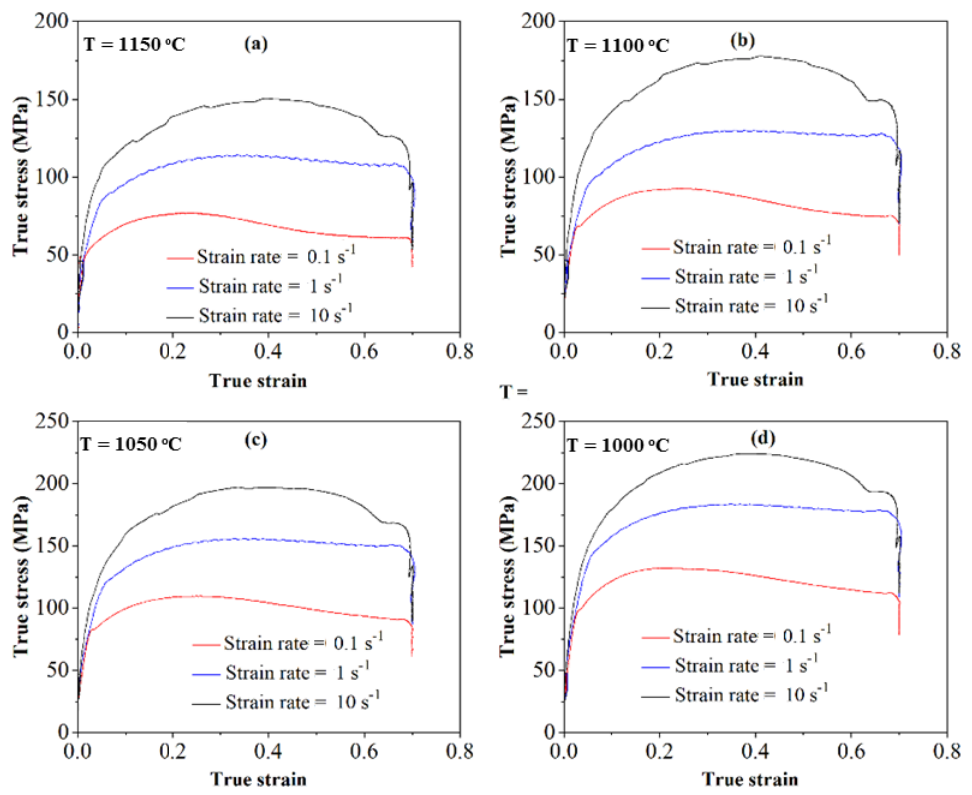
Figure 3. True stress – strain curves of 17-4PH steel at different temperatures and strain rates. ( a ) 1150 °C; ( b ) 1100 °C; ( c ) 1050 °C; ( d ) 1000 °C.